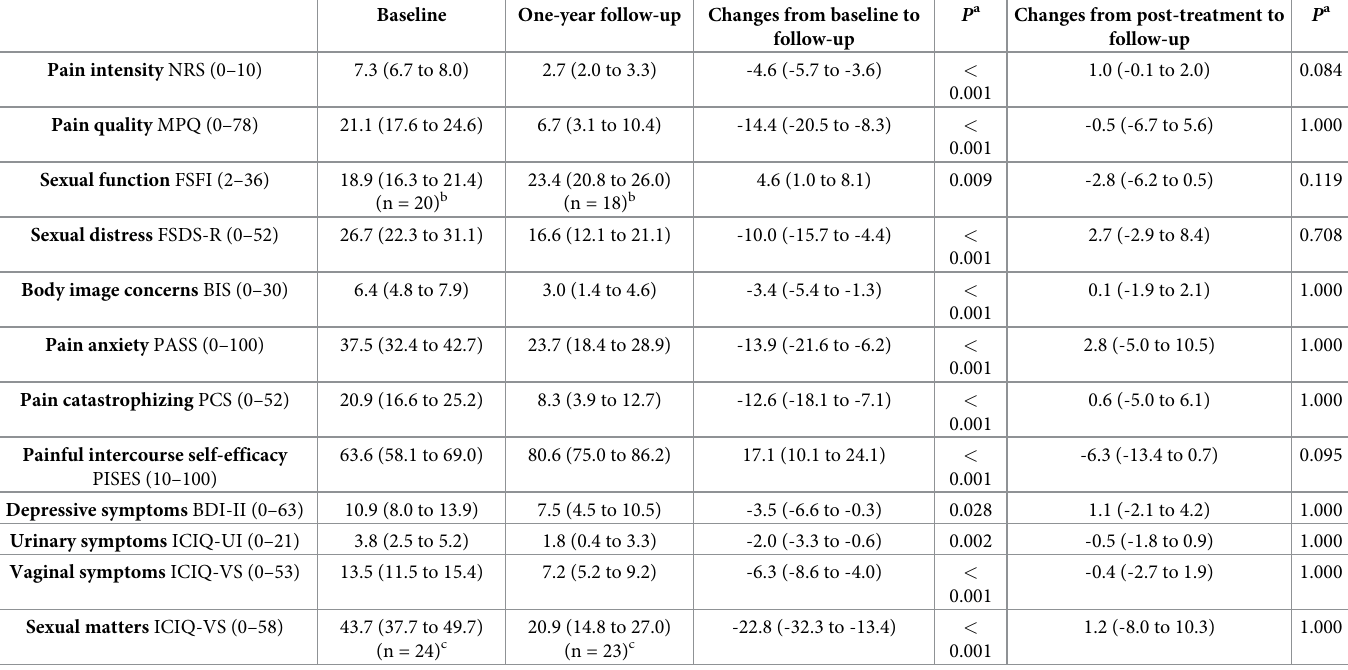
Table 2. Outcomes at baseline (n = 31) and one-year follow-up (n = 29) and changes from baseline and post-treatment to one-year follow-up.